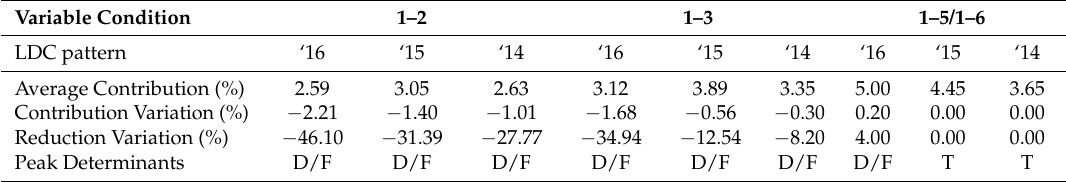
Table 9. Summary of sensitivity simulation results with sustained response period.